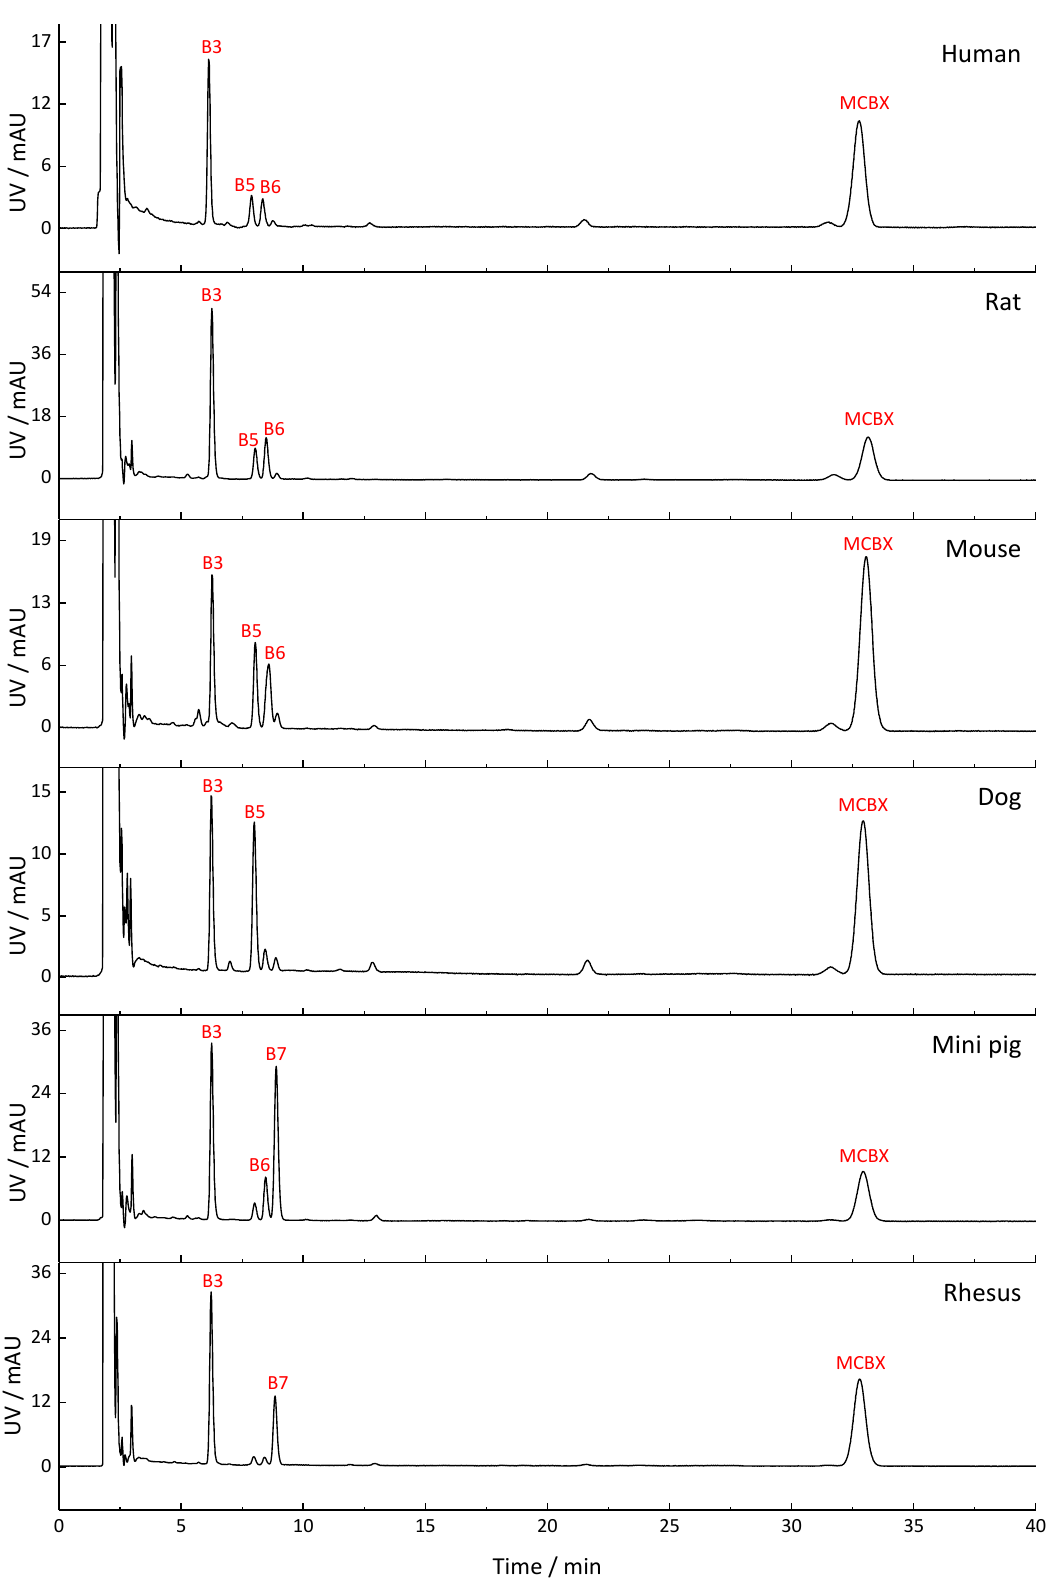
Figure 3. Metabolite profiles of MCBX generated in liver microsomes from humans and different animal species. Detection wavelength was 275 nm. In the chromatograms, only metabolite peaks accounting for at least 10% of the total metabolite peak area are labeled. A comprehensive list of the detected metabolites can be found in Table 3.